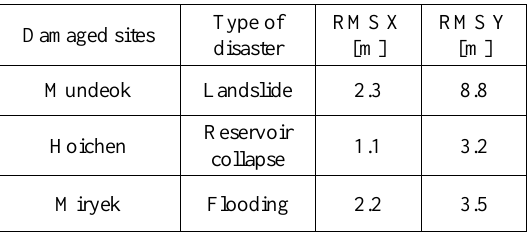
Figure. 5. Small UAVs operation in disaster field